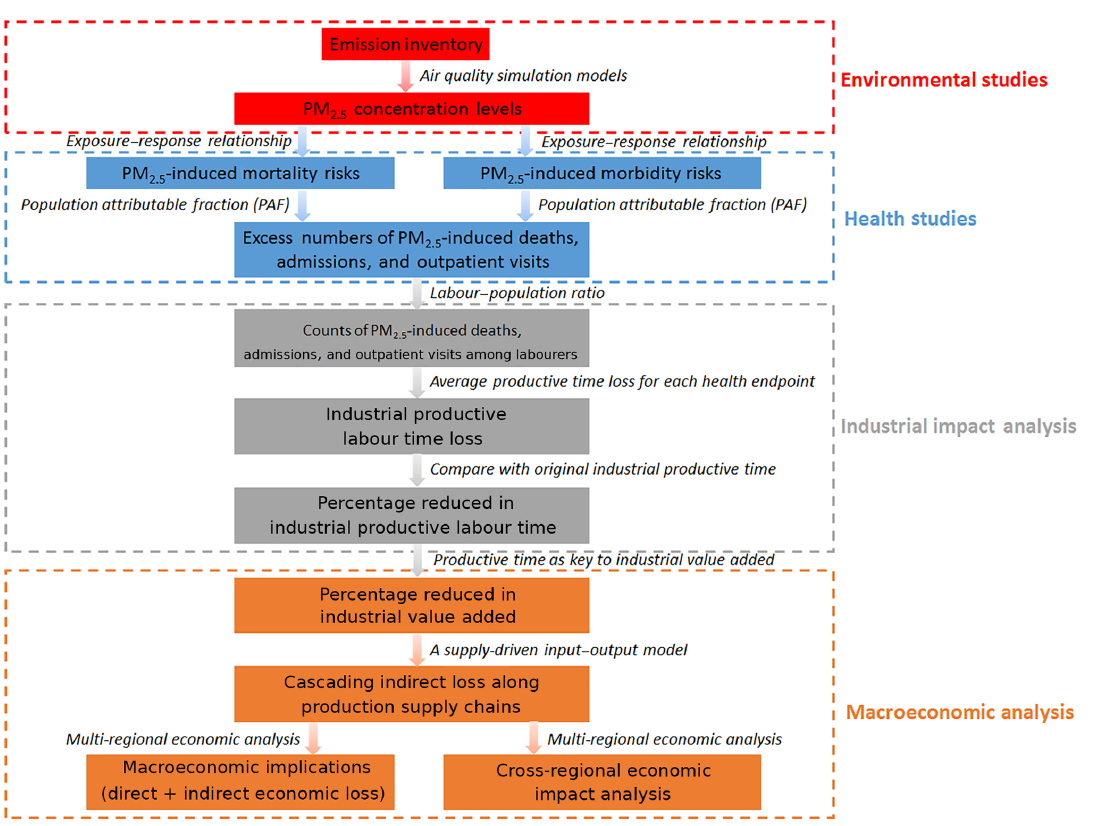
Figure 1. Methodological